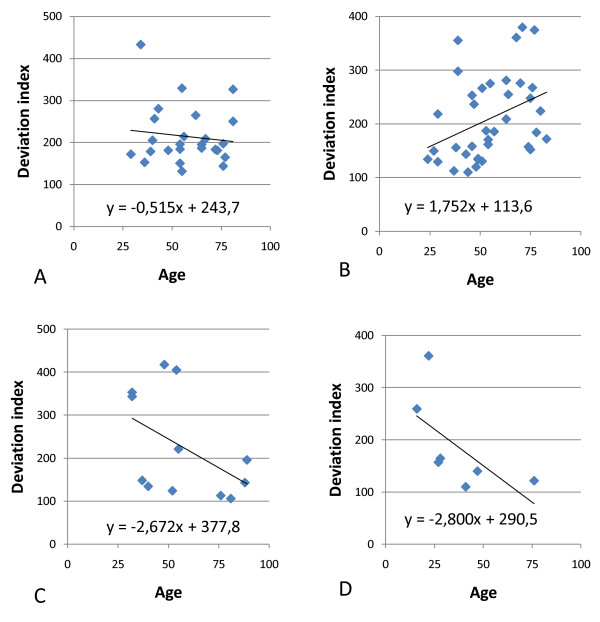
Relationship between age and deviation index for A) females of M libraries, B) males of M libraries, C) females of V libraries and D) males of V libraries.